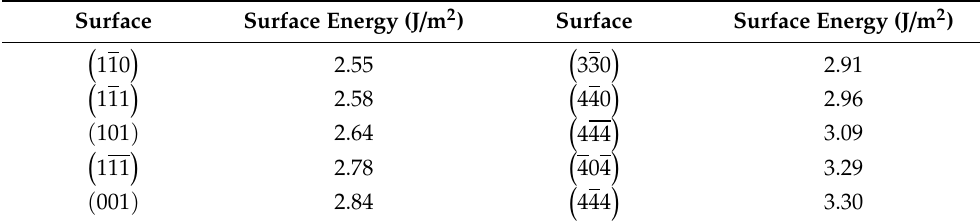
Table 1. Surface energy results for the h-Fe 7 C 3